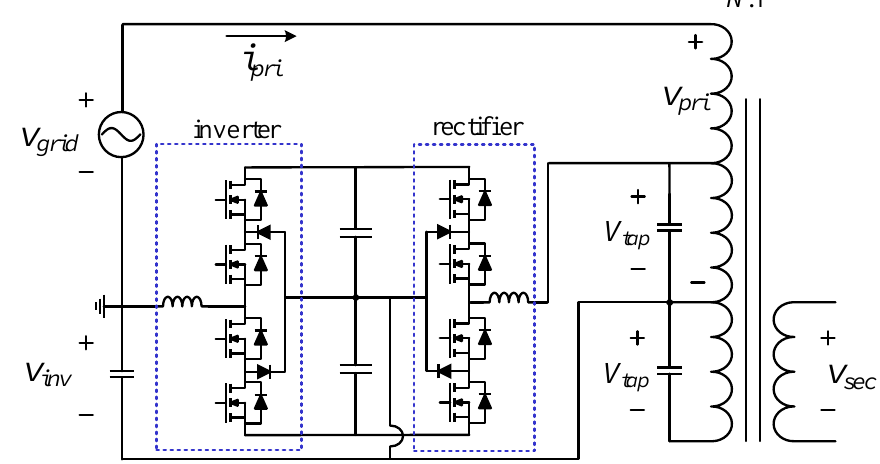
Figure 5. Circuit configuration of proposed two stage active hybrid solid state transformer.